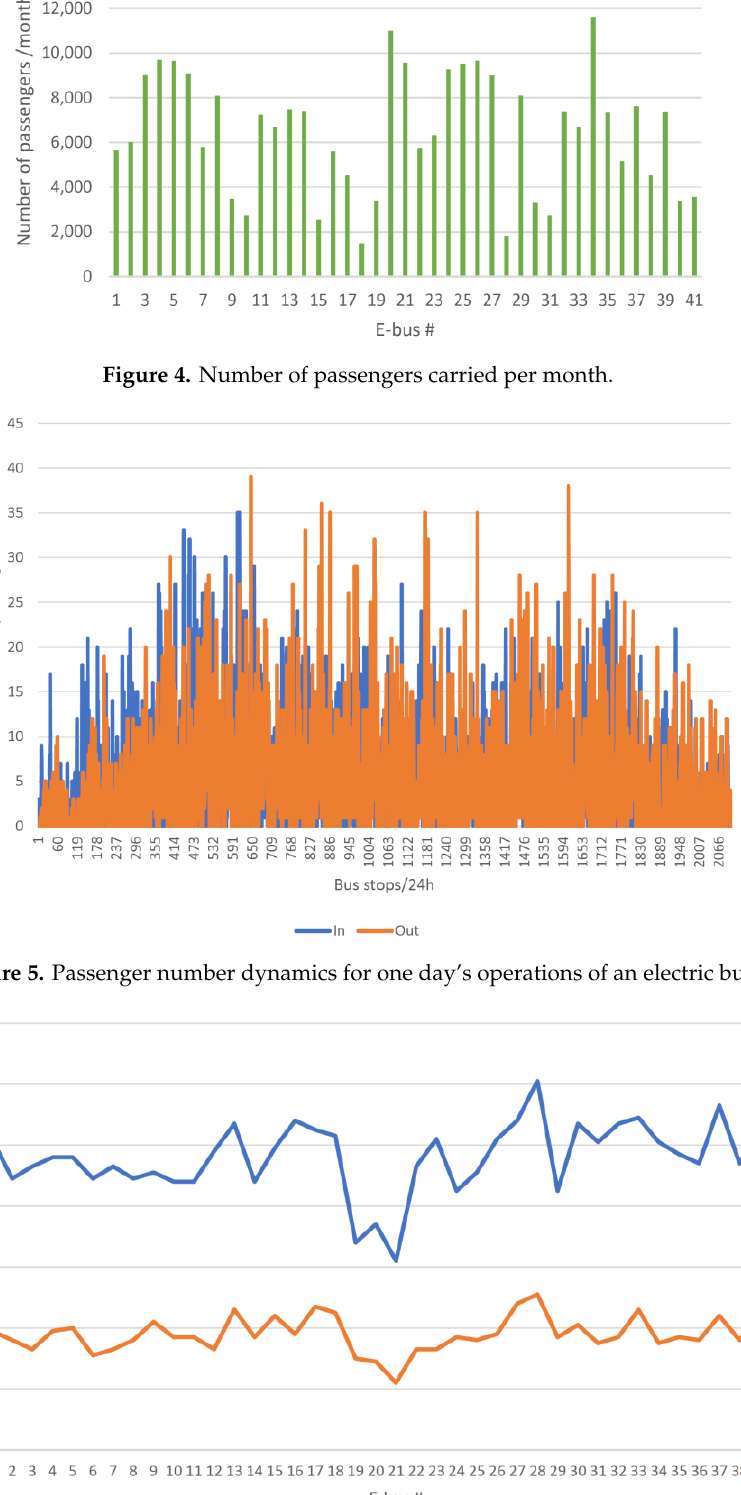
Figure 3. Number of kilometers traveled annually per each e-bus: ( a ) LiFePO 4 battery bus type; and ( b ) NMC battery bus type.